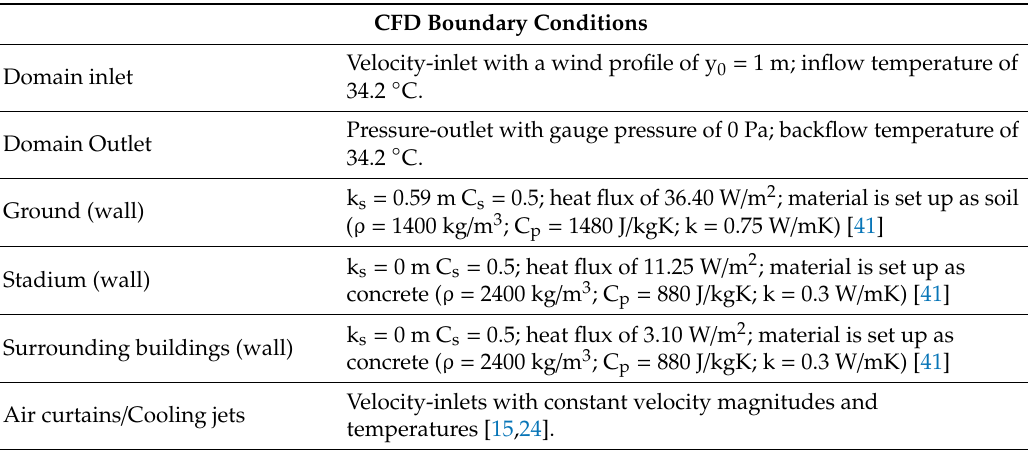
Table 1. Boundary conditions for the Computational Fluid Dynamics (CFD) models.